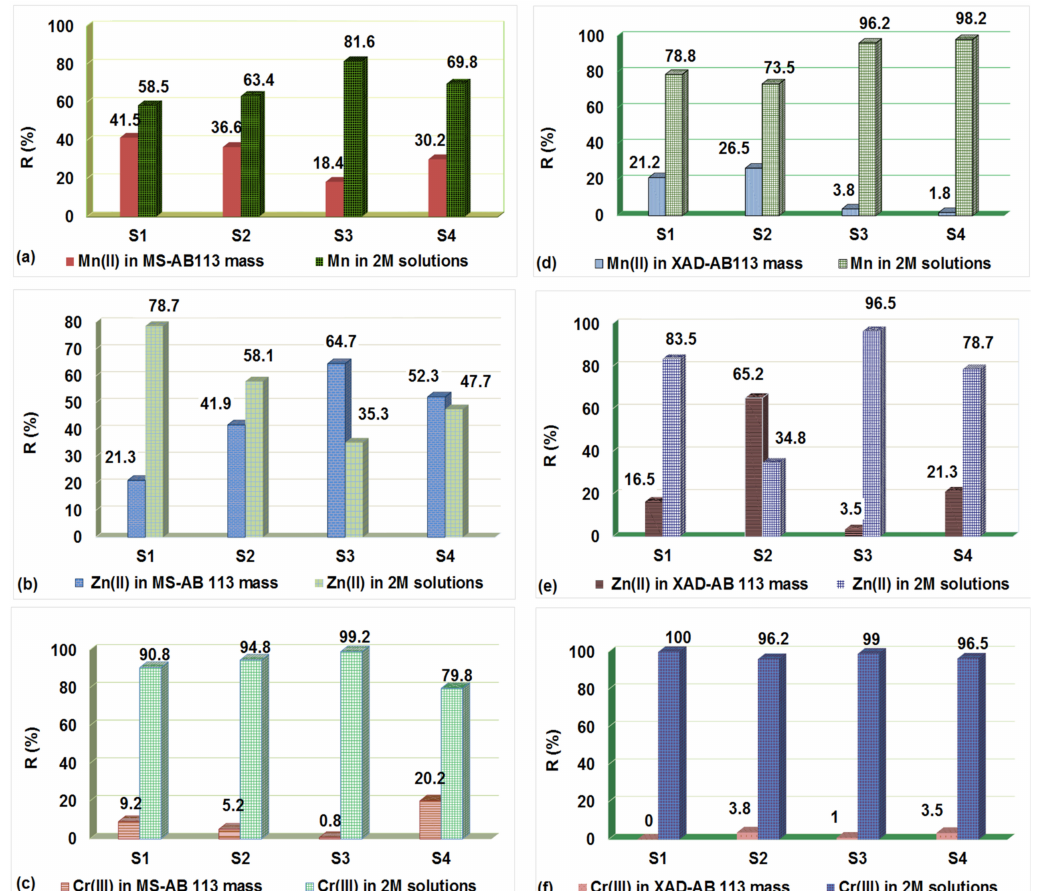
Figure 8. Effect of HCl solutions on the metal ions desorbed by: MS-AB 113 ( a – c ) and XAD7HP-AB 113 ( d – f